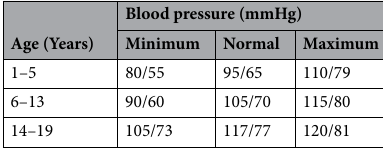
Table 1. Blood pressure by age 31